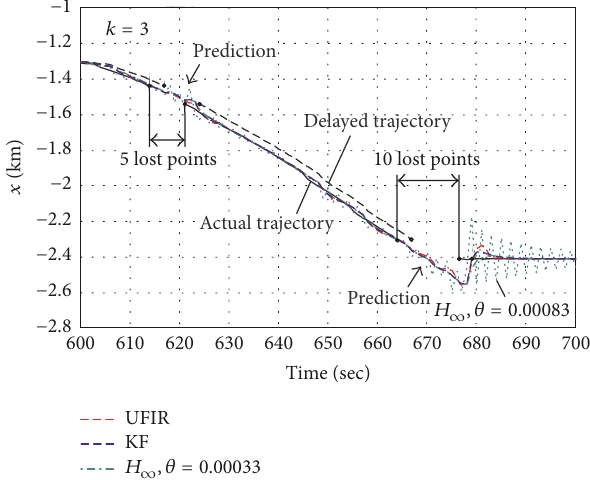
Figure 6: Vehicle tracking with temporary missing data in the east direction 𝑥 by the UFIR filter, KF, and 𝐻 ∞ filter, all augmented withthepredictionoption.Tunedimproperly,the 𝐻 ∞ filterbecomes unstable and prone to divergence, as in Figure